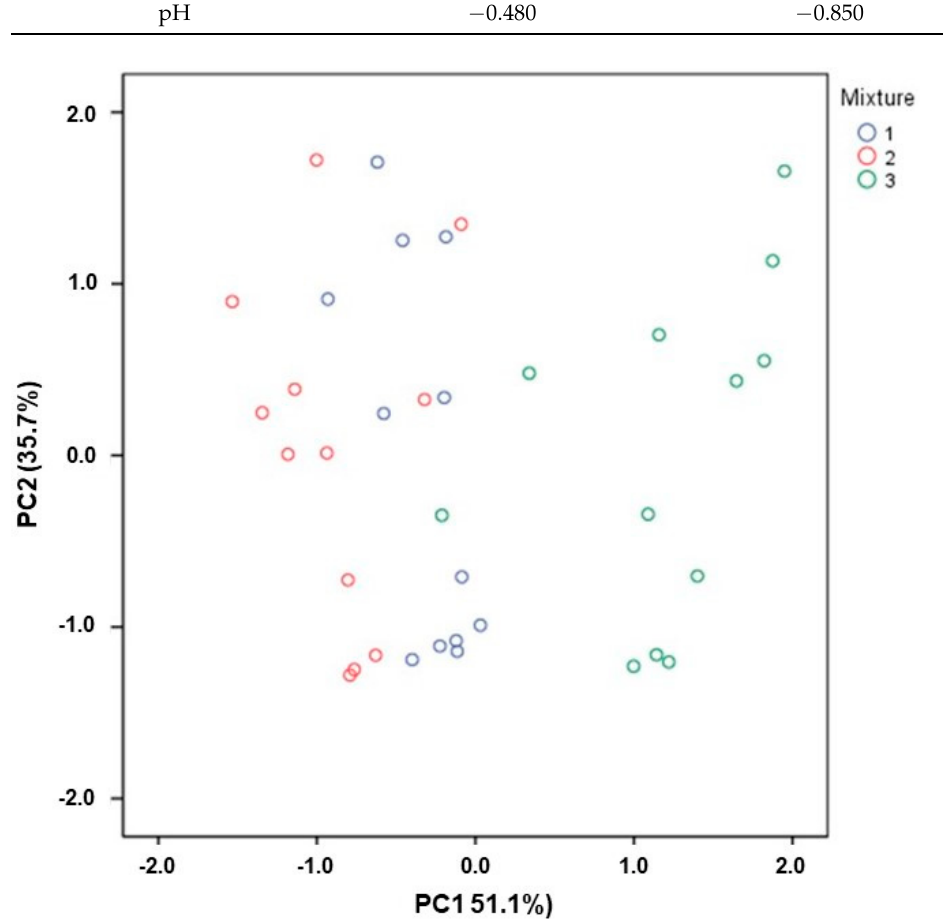
Figure 3. PCA factor scores of variations in C, N, pH, and EC in the three mixtures studied.